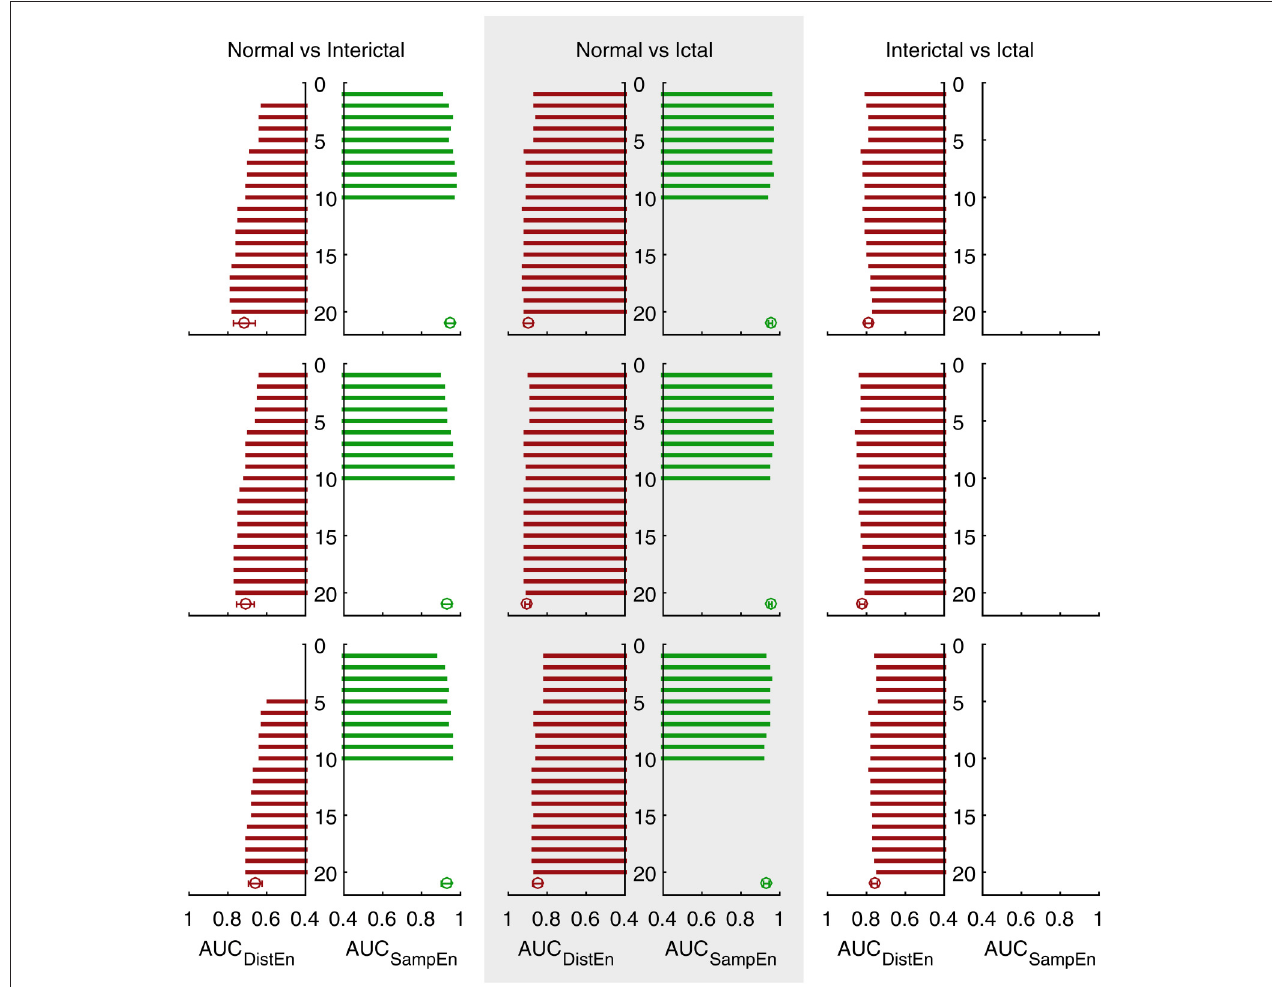
FIGURE 3 | Area under the ROC curves (AUC) of three different protocols (see Supplementary Figures 1–3 for detailed ROC results). Bars show AUC of ROC curves with feature indices from 1 to 20. Error bars show the average and standard deviation of the corresponding AUC sets (undefined values